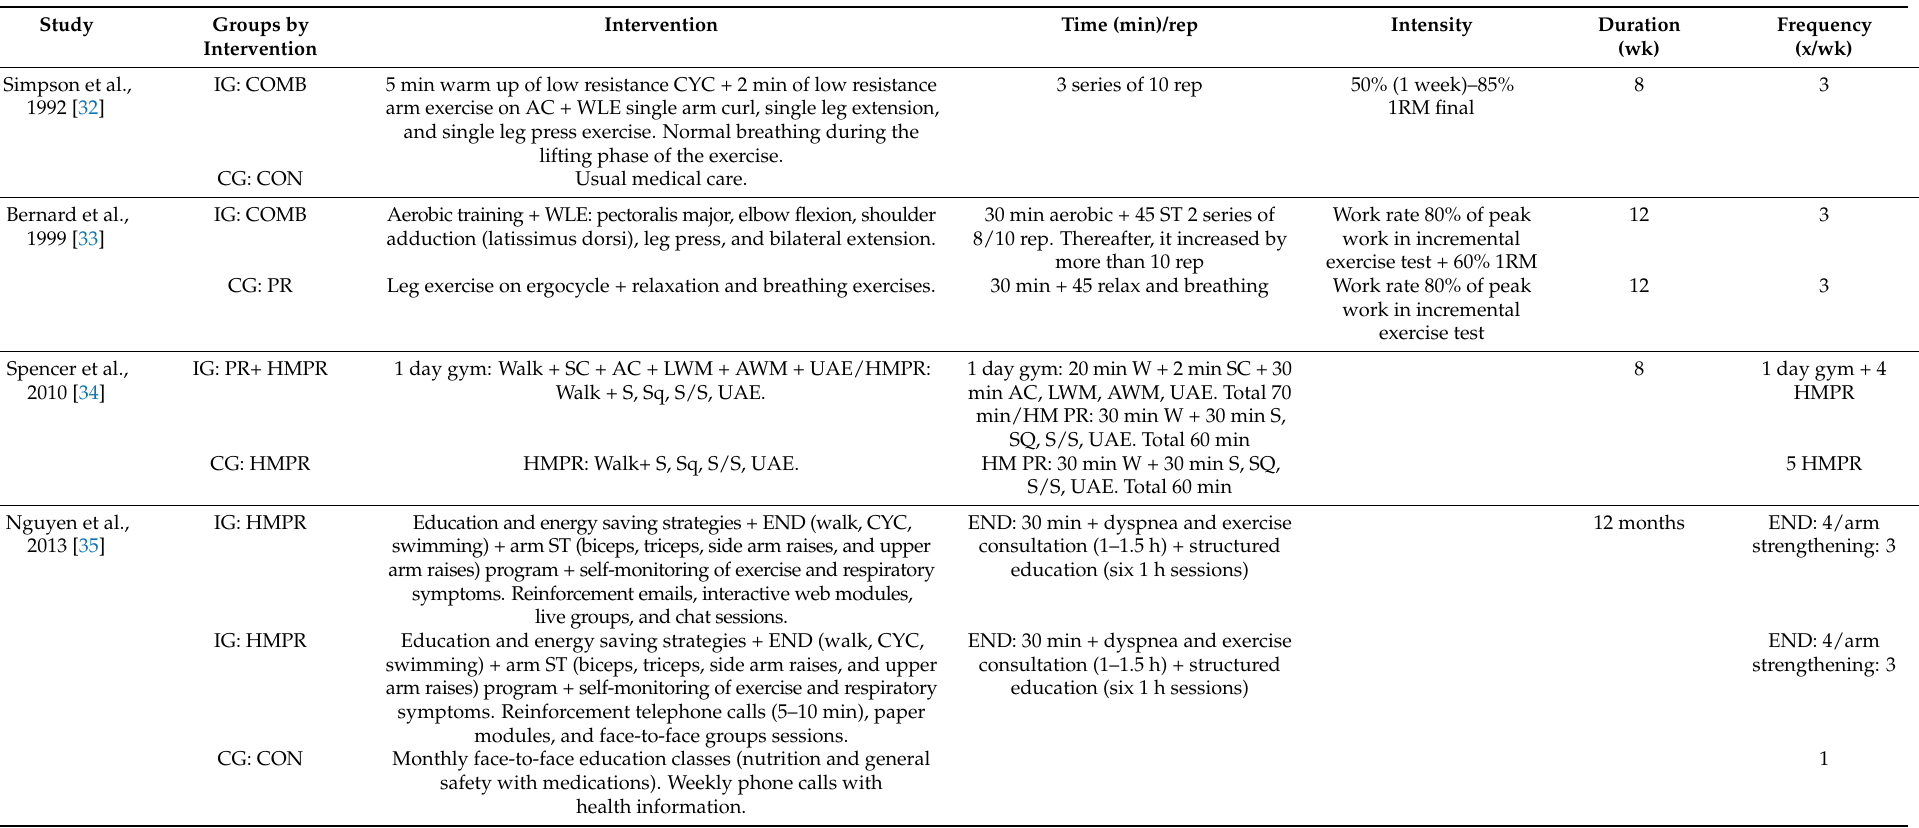
Table 2. Characteristics of the interventions described in the included